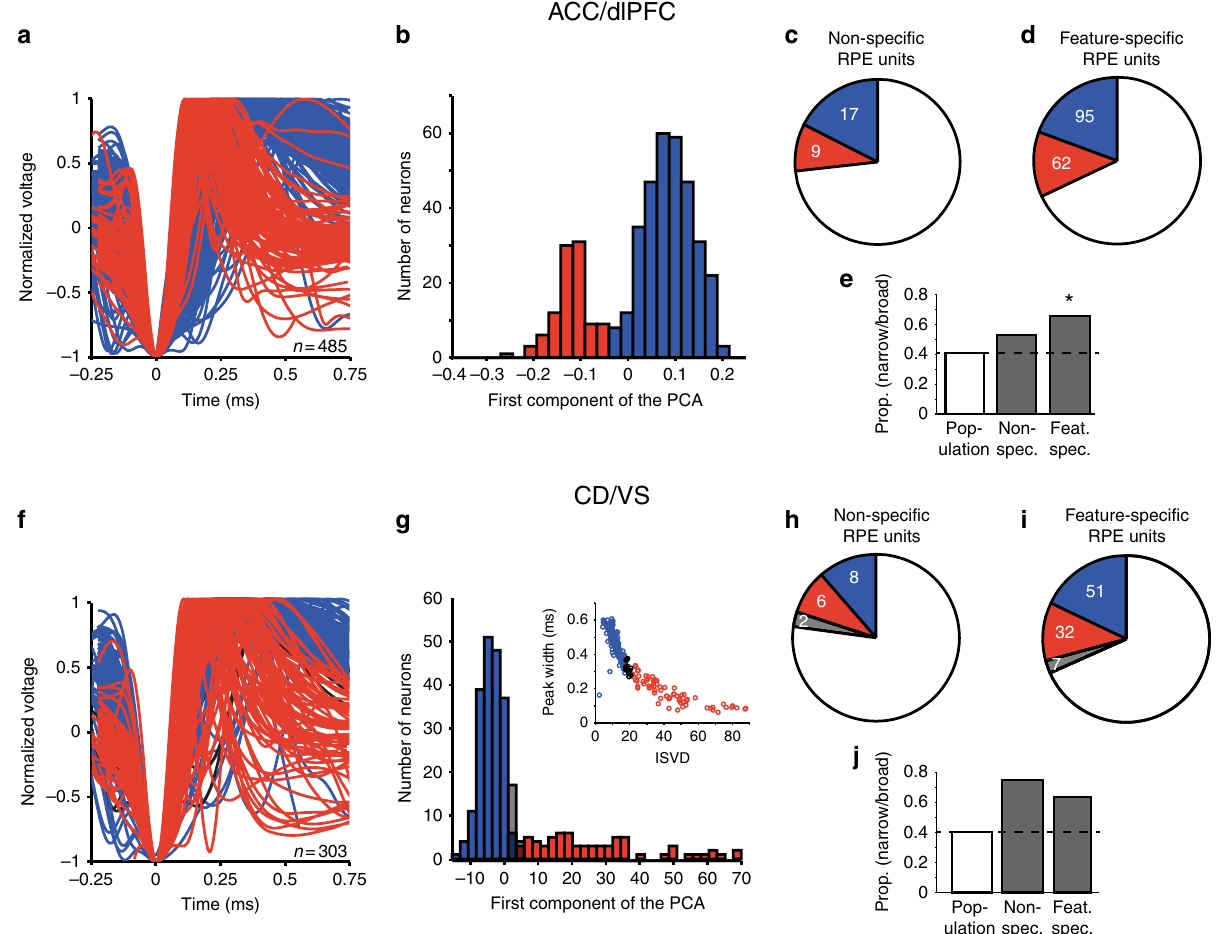
Fig. 8 Cell-type classi fi cation of RPE units. a – e for ACC/dlPFC units. a Waveforms of all highly isolated single units recorded, identi fi ed as putative interneurons (narrow-spiking, red), putative pyramidal cells (broad-spiking, blue). b Histogram of the fi rst component of the PCA using peak-to-trough duration and time to repolarization to separate neurons into putative interneurons and putative pyramidal cells. c Proportion of nonspeci fi c RPE encoding neurons identi fi ed as narrow- (red) or broad-spiking (blue), in addition to nonsingle units (white). d Proportion of feature-speci fi c RPE encoding neurons identi fi ed as narrow- or broad-spiking. e Ratio of narrow to broad-spiking neurons identi fi ed in the population, for nonspeci fi c and feature-speci fi c RPE encoding neurons. Black asterisk indicates p < 0.05 (chi-square test). f – j for CD/VS units. f Waveforms of all highly isolated single units recorded, identi fi ed as putative interneurons (red) or putative medium spiny neurons (MSNs, blue), or unidenti fi ed (black). g Histogram of the fi rst component of the PCA using peak width and initial slope of valley decay (ISVD) to separate neurons into putative interneurons and MSNs. Inset shows the scatterplot of peak width versus ISVD across neurons. h Proportion of nonspeci fi c RPE encoding neurons identi fi ed as putative interneurons or MSNs, or unidenti fi ed (gray), in addition to nonsingle units (white). i Proportion of feature-speci fi c RPE encoding neurons identi fi ed as putative interneurons or MSNs or unidenti fi ed. j Ratio of putative interneuron/MSN in the population, for nonspeci fi c and feature-speci fi c RPE encoding